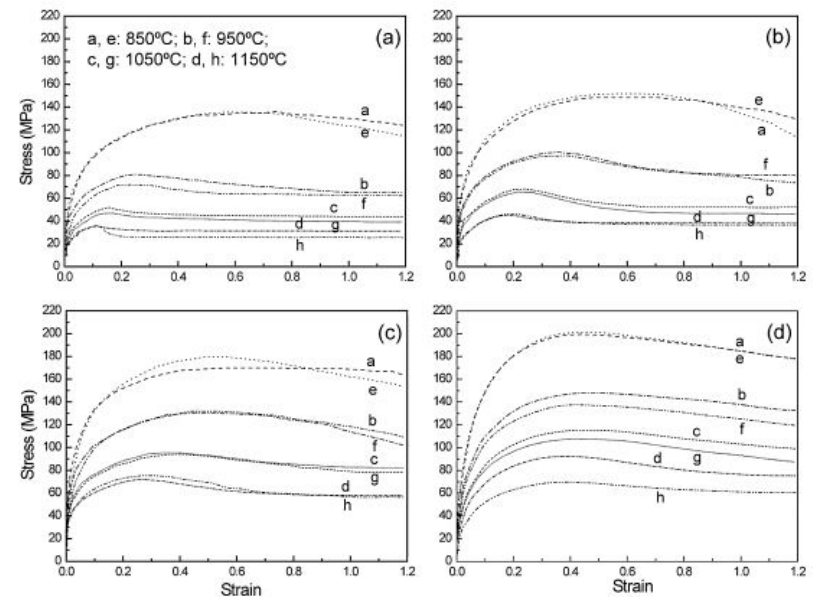
Figure 34. Stress–strain curves of air-cooled (a–d) and water-cooled (e–h) Al–V–N micro-alloyed steel after solution treatment deformed at various strain rates: ( a ) 0.01 s − 1 ; ( b ) 0.1 s − 1 ; ( c ) 1 s − 1 ; and ( d ) 5 s − 1 [200] .